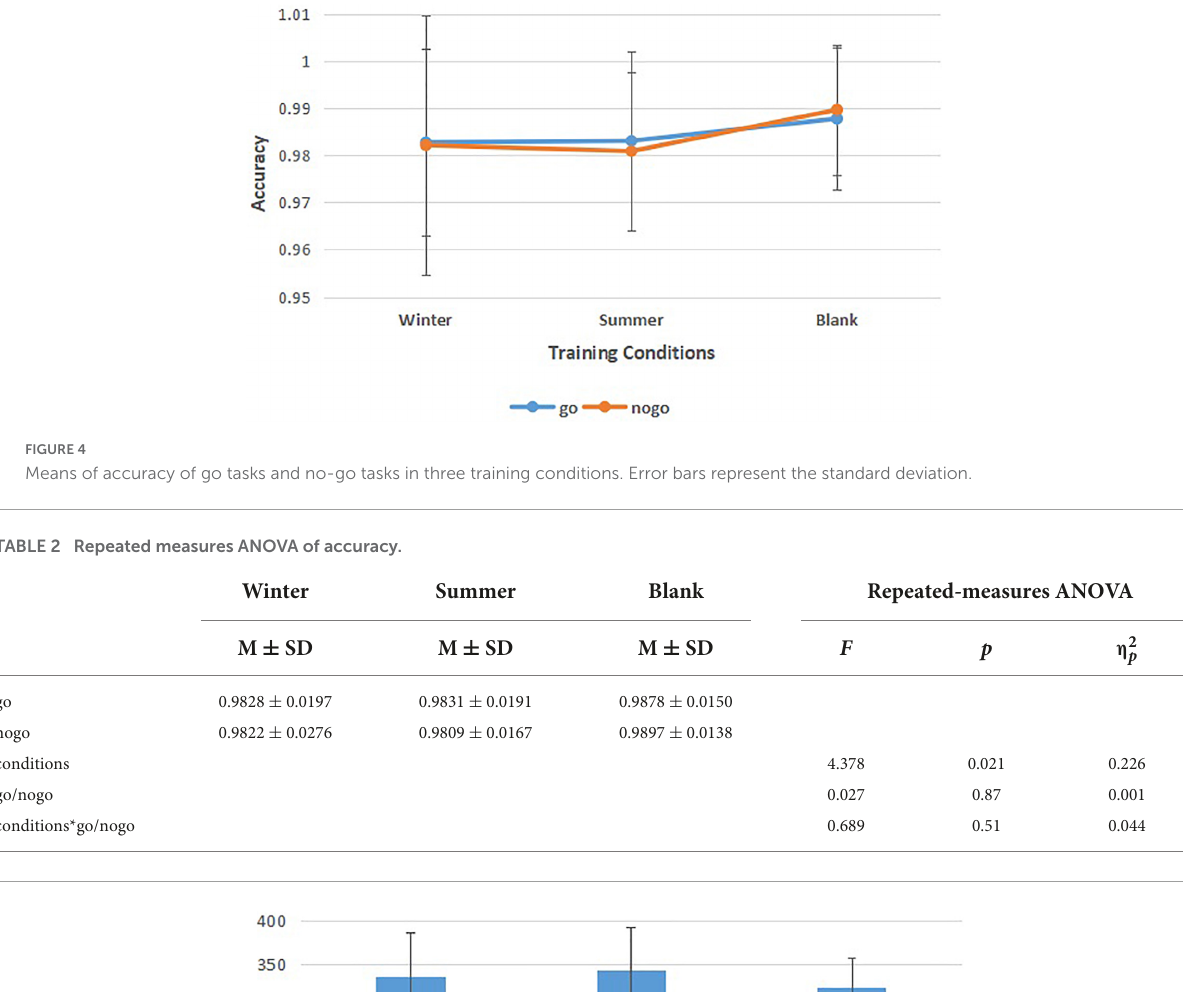
FIGURE5 Means of reaction time of go tasks in three training conditions. Error bars represent the standard deviation.